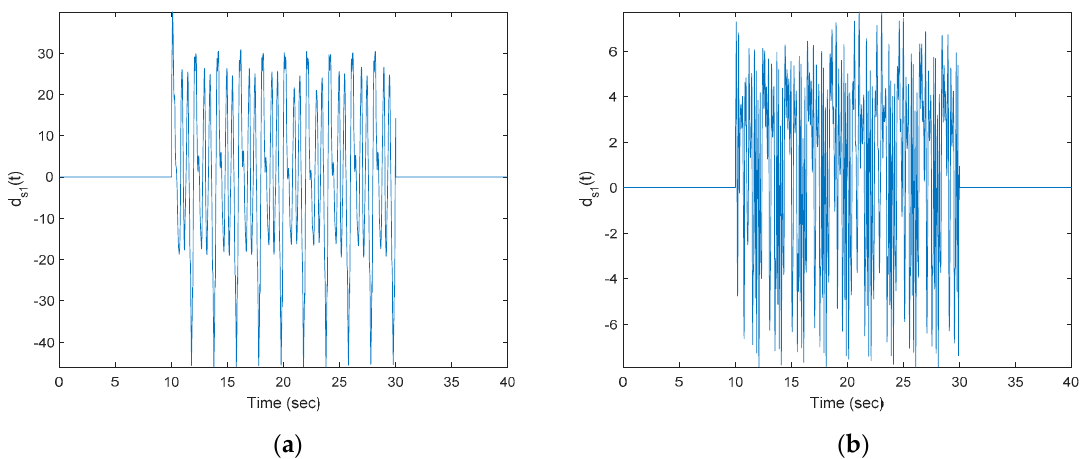
Figure 5. ( a ) Input disturbance d s 1 ( t ) (state-dependent disturbance inside) and ( b ) state-dependent disturbance in d s 1 ( t ) .